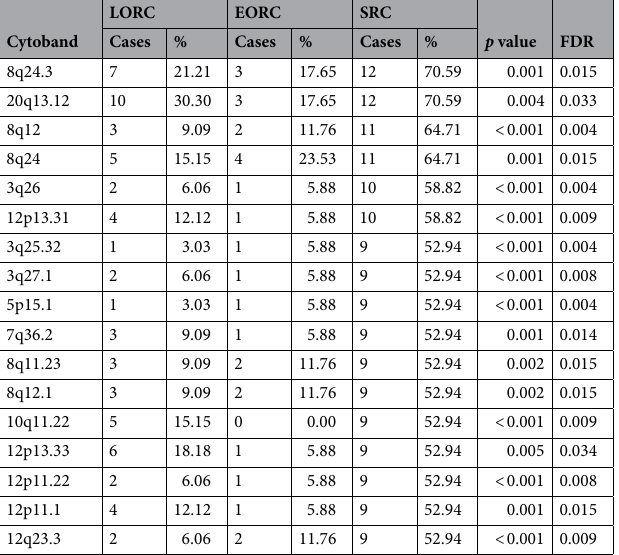
Table 3. Gains occurring with statistically significantly different frequencies in the three groups. EORC, early- onset rectal cancer; FDR, false discovery rate; LORC, late-onset rectal cancer; SRC, synchronous rectal cancer.